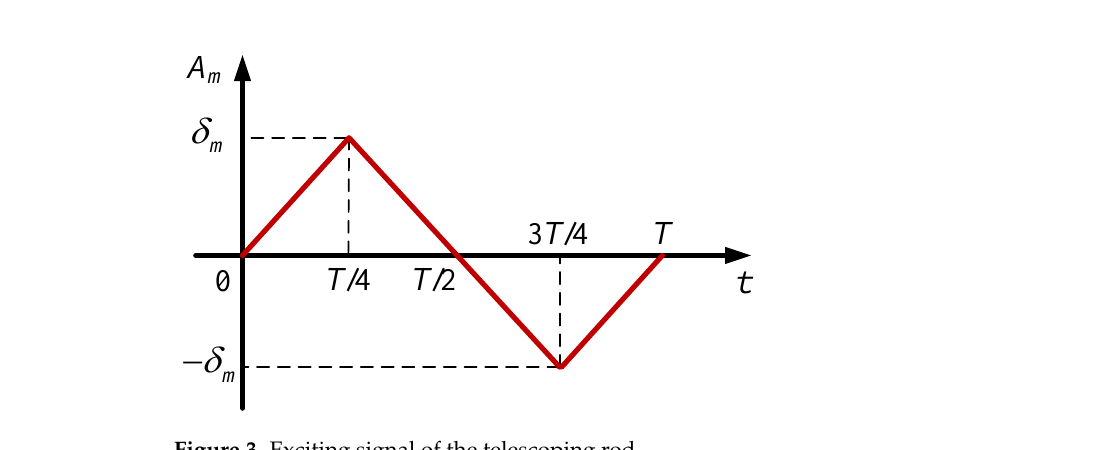
Figure 3. Exciting signal of the telescoping rod.